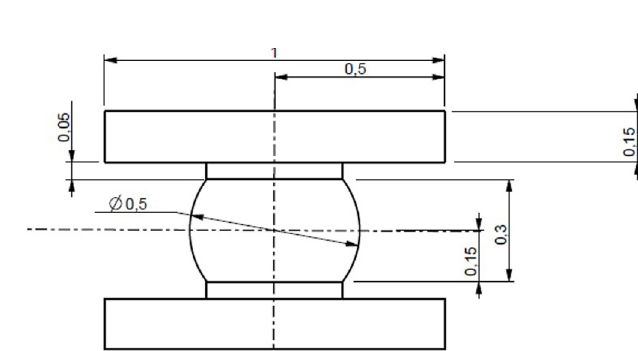
Fig. 5. Dimension details of the solder